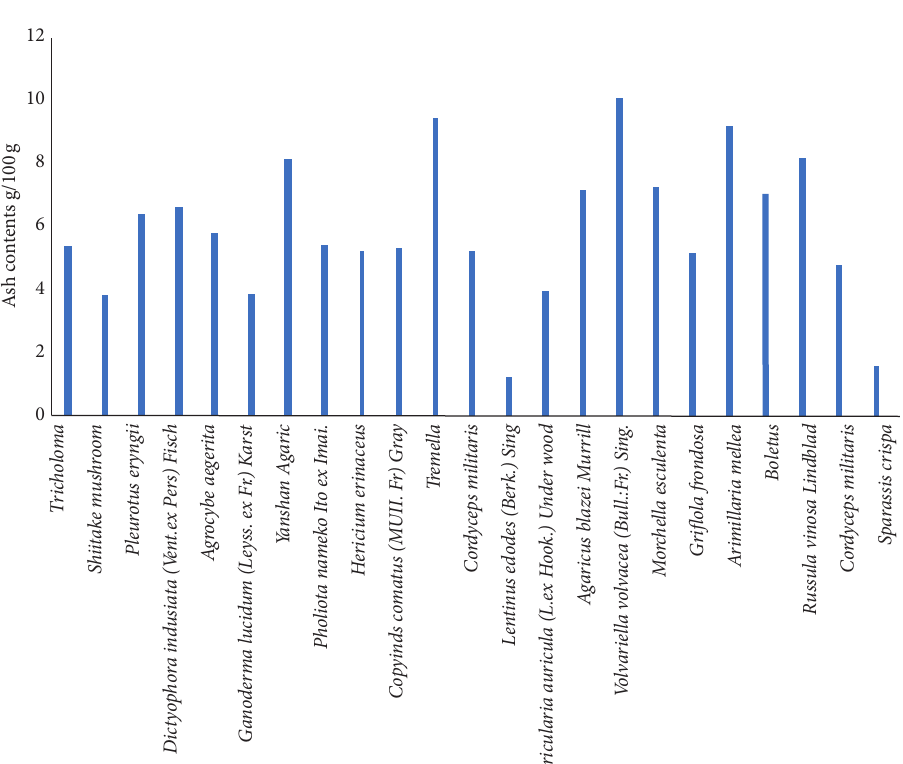
Figure 2: Ash contents of 23 kinds of edible fungi.